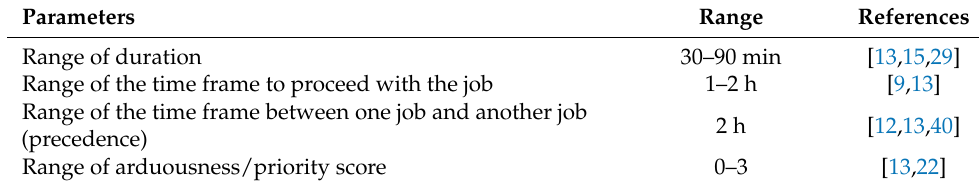
Table 3. Range of non-editable parameters for